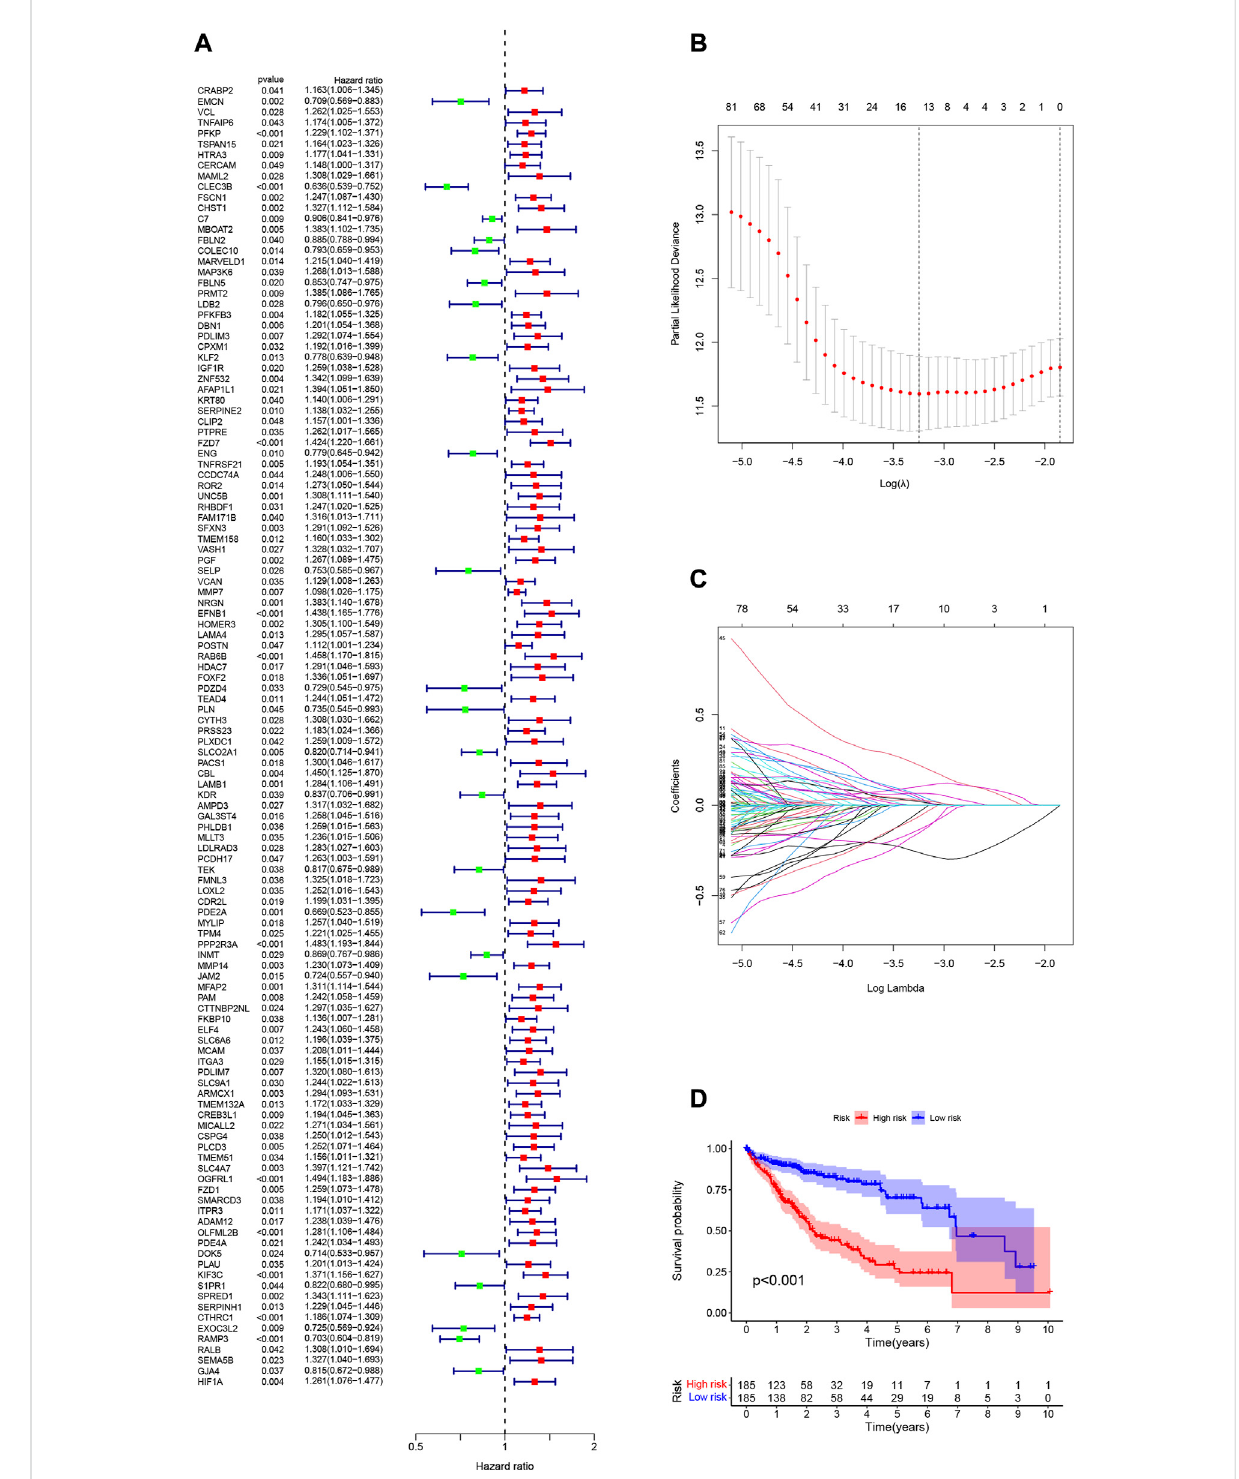
FIGURE 3 (A) 122genesassociatedwithHCCprognosisscreenedusingunivariateCoxregression. (B) Variationcurveofregressioncoef fi cientwithLog( λ ) in Lasso regression. (C) Ten-fold cross-validation for tuning parameter selection in lasso regression.Vertical lines are drawn from the best data according to the minimum criterion and 1 standard error criterion. (D) Kaplan-Meier curve analysis showed differences in overall survival between high- and low-risk groups in the TCGA-LIHC